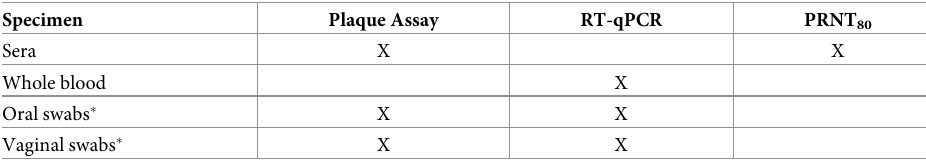
of viremia (plaque assay) and virus neutralizing antibodies (PRNT ) (Table 3). Oral and vagi- 80 nal swabs were used to detect vRNA shedding (RT-qPCR), and positive swabs were screened by plaque assay for infectious virus (Table 3). Rectal temperatures were taken during physical examinations and M00 radio telemetry devices (DSI, Saint Paul, MN USA) were used to monitor temperatures in real-time through- out the study [79]. To generate a single data point every 30 seconds, temperature data points were averaged and then statistically filtered to remove noise and signal artifacts (Notocord-